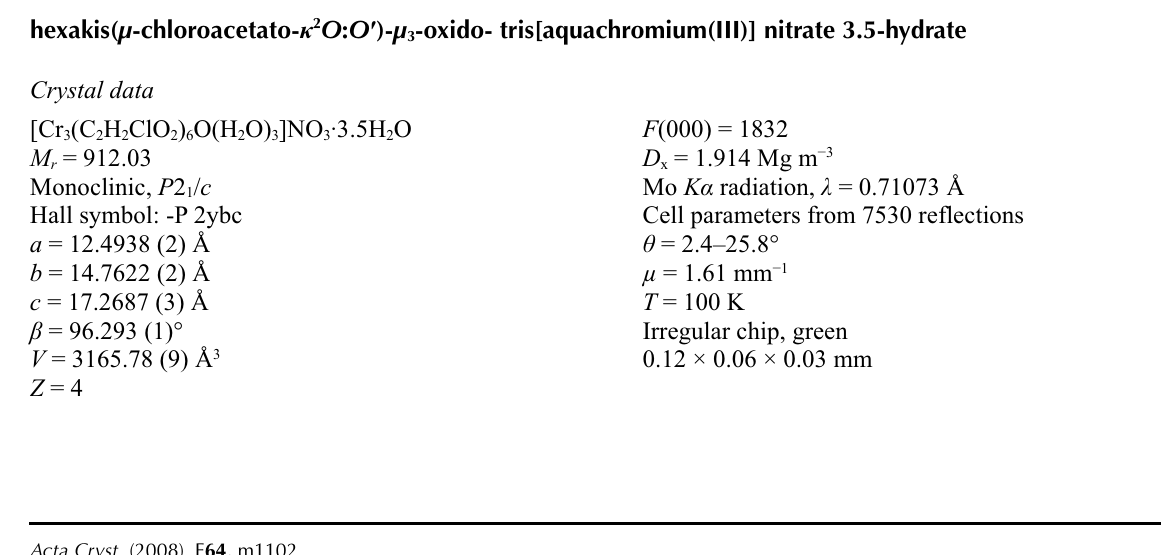
Molecular structure of the title compound. Displacement ellipsoids are drawn at the 50% probability level. The minor disorder components are not shown. The water molecule O7w has 0.5